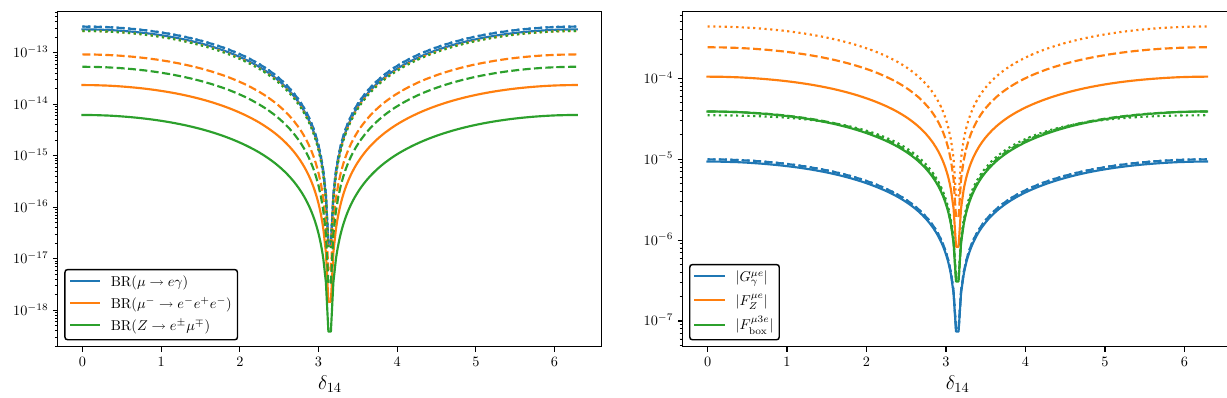
Fig. 3 Dependence of cLFV observables and several form factors (contributing to the different cLFV decay rates) on the CP violating Dirac phase δ μ → e γ ) (blue), BR( μ → 3 e ) (orange) and BR( Z → e μ ) (green); on the right 14 (all other phases set to zero). On the left panel we present BR( βα βα | (orange) and | F β 3 α | (green), choosing for illustrative purposes α = e and β = μ . In both panels, solid, dashed and one finds | G γ | (blue), | F Z box dotted lines respectively correspond to the following heavy fermion masses: m 4 = m 5 = 1 , 5 , 10 TeV